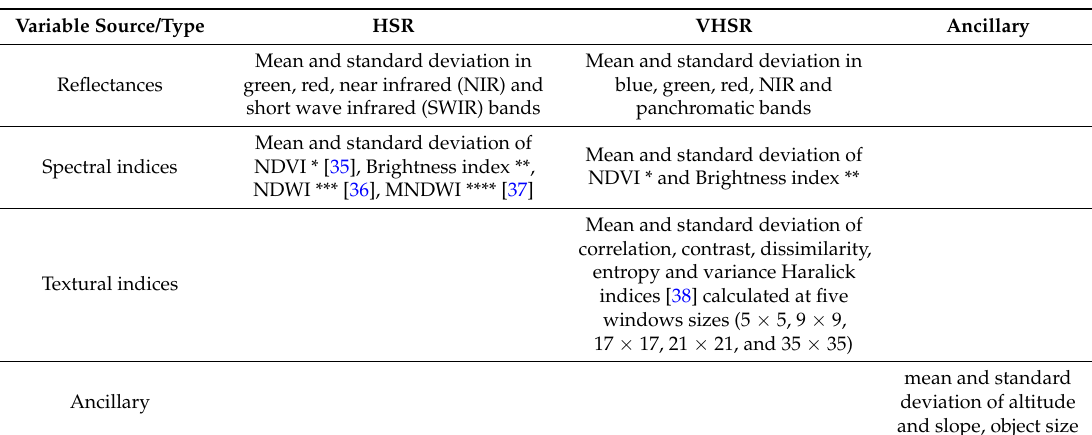
Table 2. Description of the variables extracted to build the learning database according to their type (reflectances, spectral indices, textures, and ancillary) and source (high spatial resolution imagery (HSR), very high spatial resolution imagery (VHSR), and